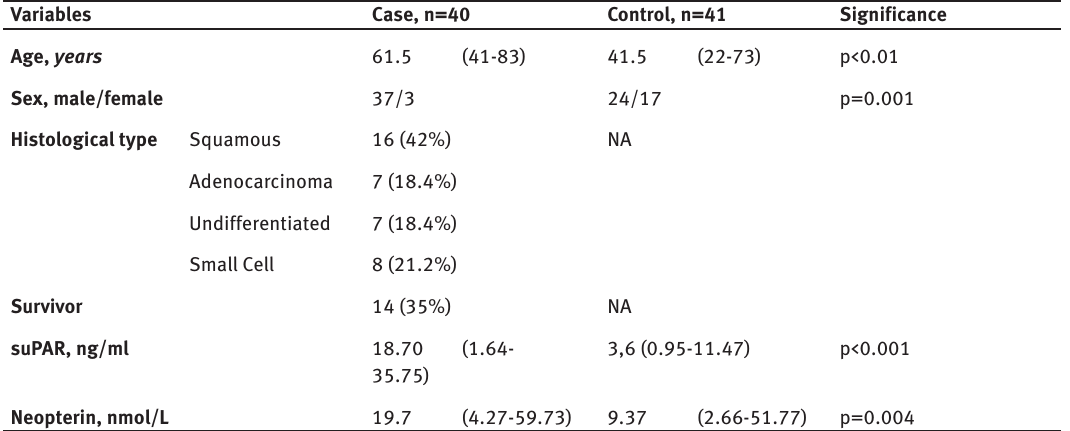
Table 1: Clinical and laboratory features of the subjects.